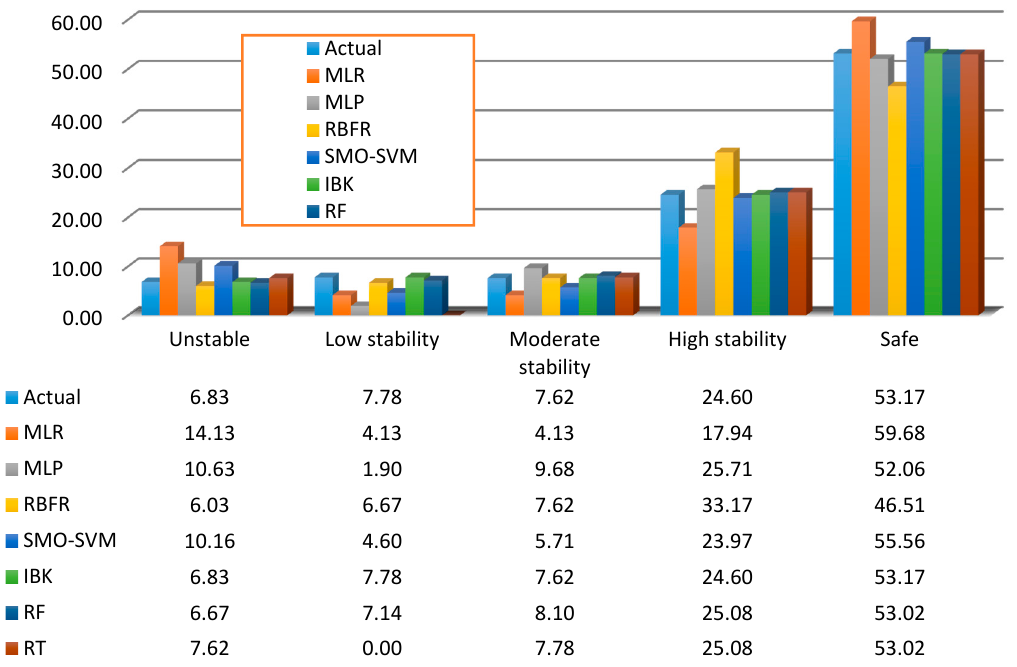
Figure 10. The column chart showing the percentage of stability classes.